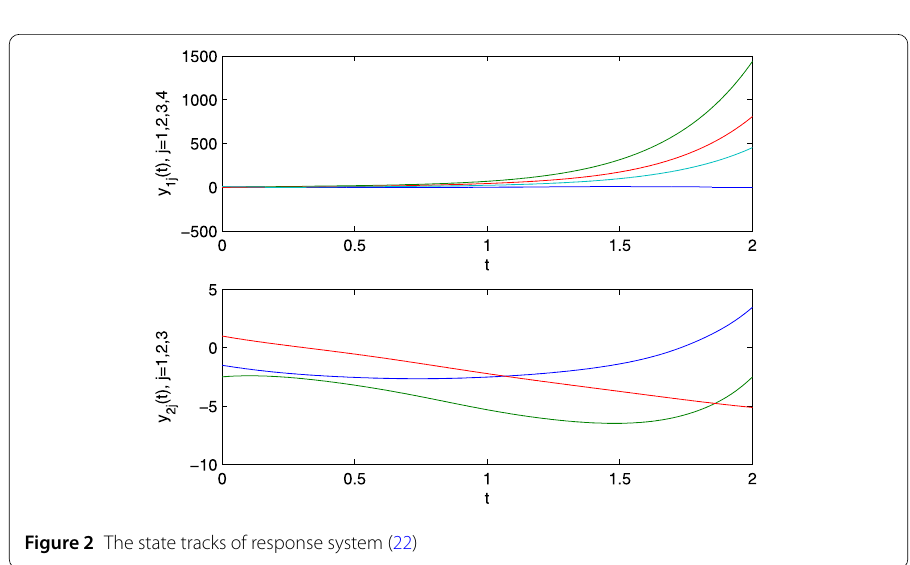
Figure 2 The state tracks of response system